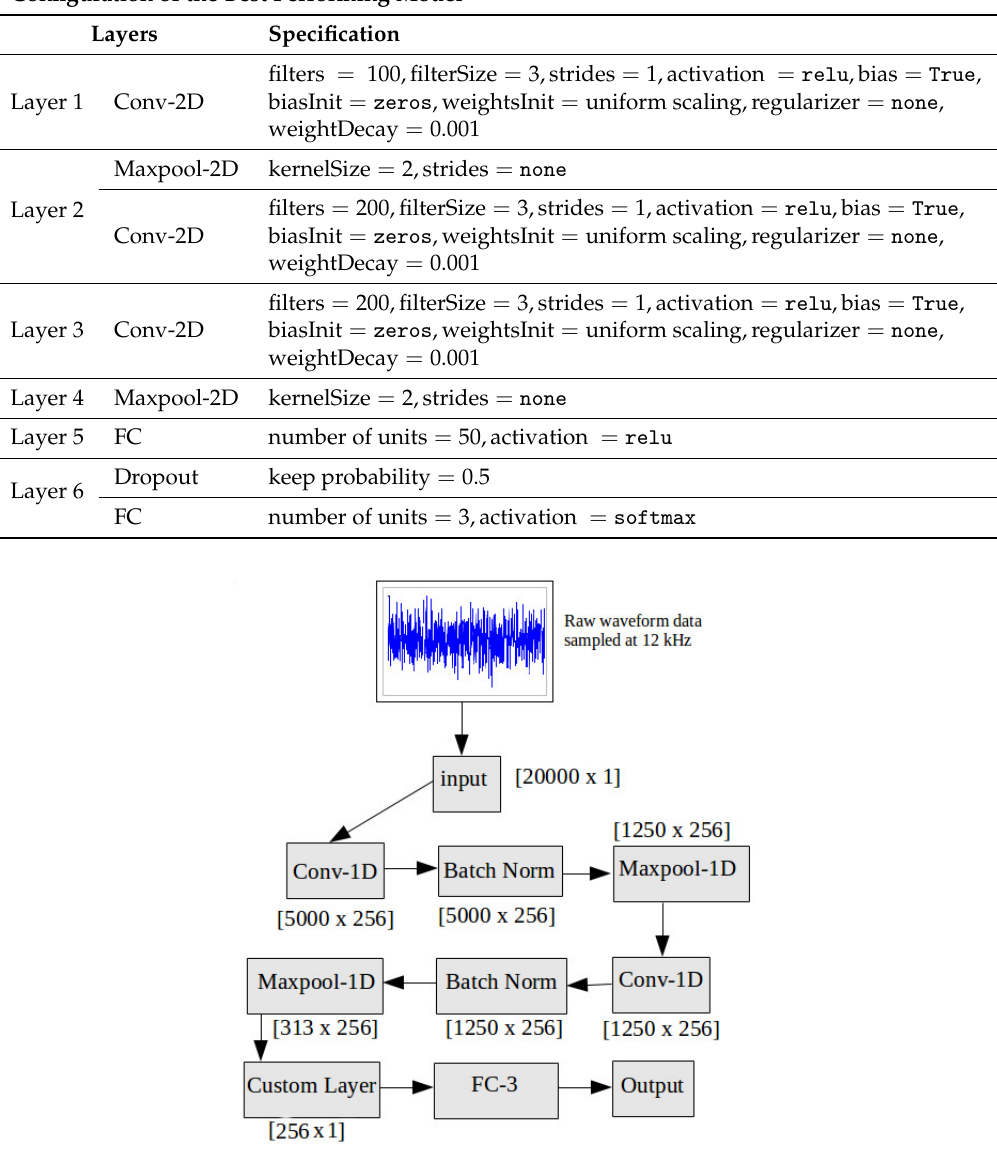
Figure 7. RawConvNet Architecture. The numbers below each box, except for the input, are the dimensions of the resultant feature map following the corresponding operation in the